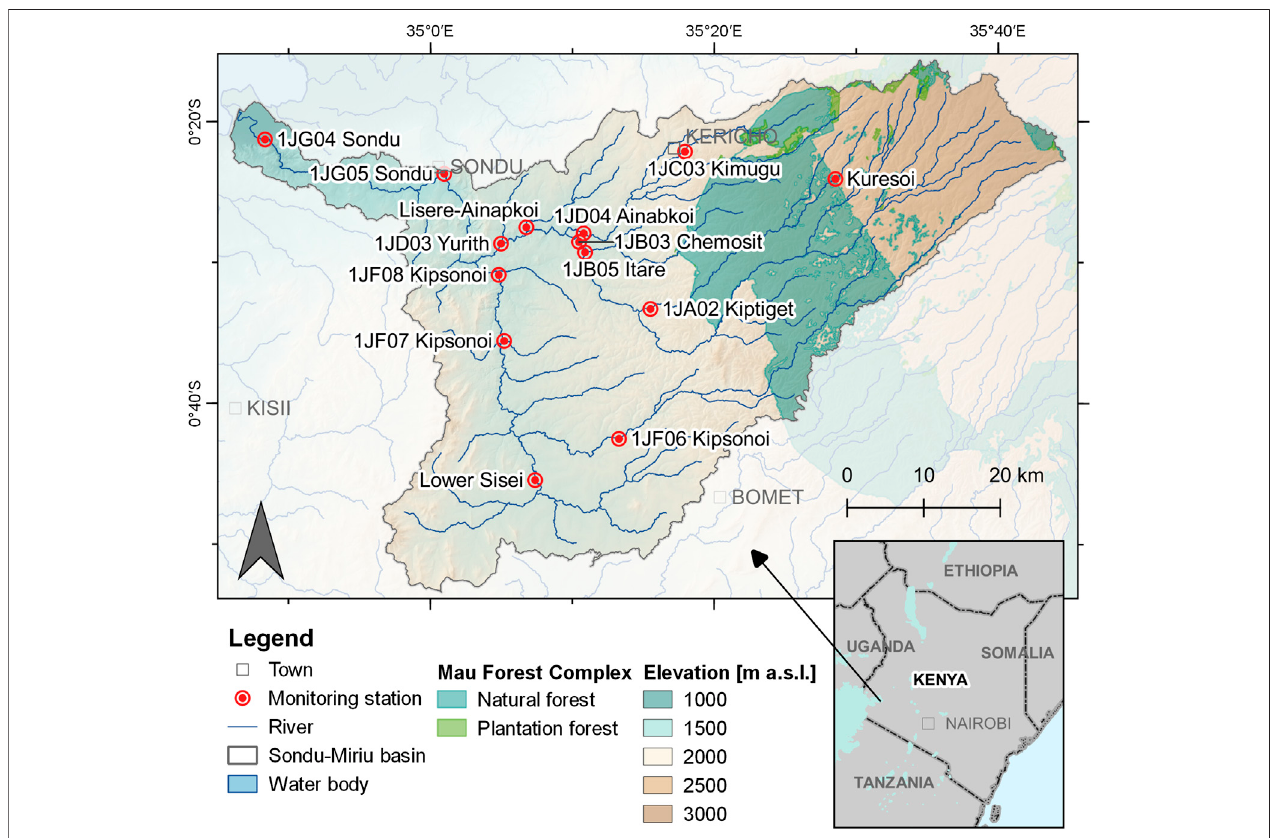
FIGURE1| MapoftheSondu-MiriubasininwesternKenya,indicatingthecitizensciencewaterlevelmonitoringstations. CoordinatesaredisplayedinWGS1984.